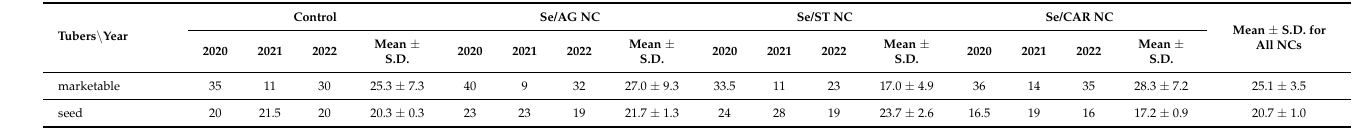
Table 1. The structure of the potato crop (the percentage of marketable and seed tubers) according to the results of three years of field